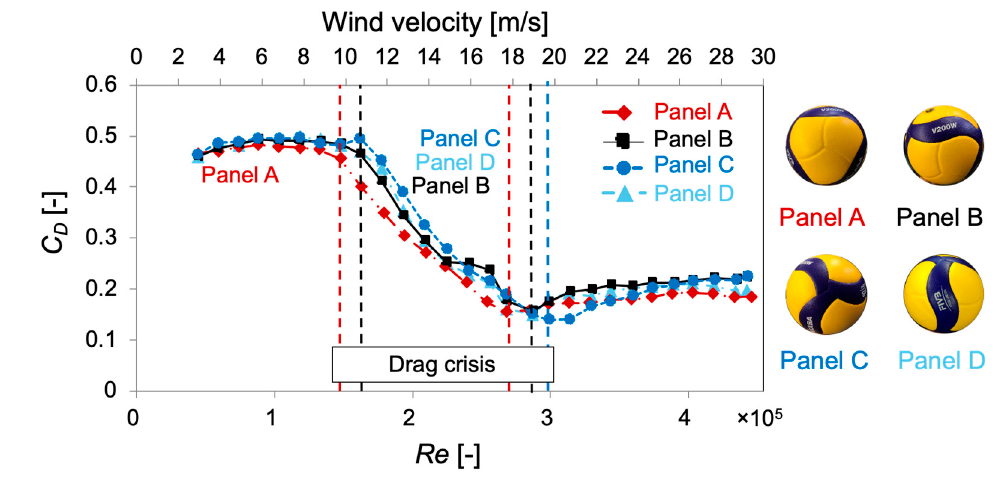
Figure 6. Relationship between Reynolds number and drag coefficient on V200W.